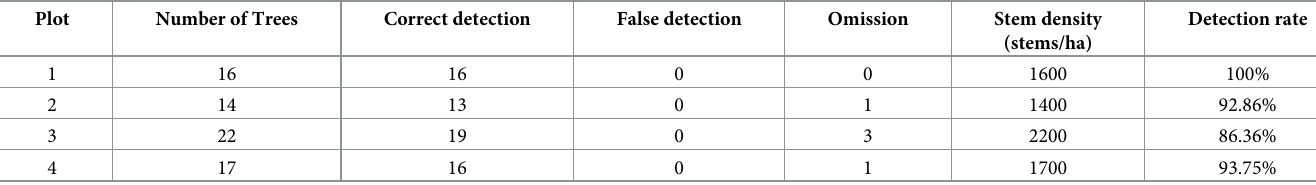
cloud data with the lowest height of about 10 cm and with a diameter of 0.6 m. The local ground is relatively flat and the DBH of the tree is below 20 cm. The inclination angles of the fitted local ground planes are about 3 degrees, and the related height errors are about 1 cm. Therefore, the tilted ground has little effect on the DBH estimation.